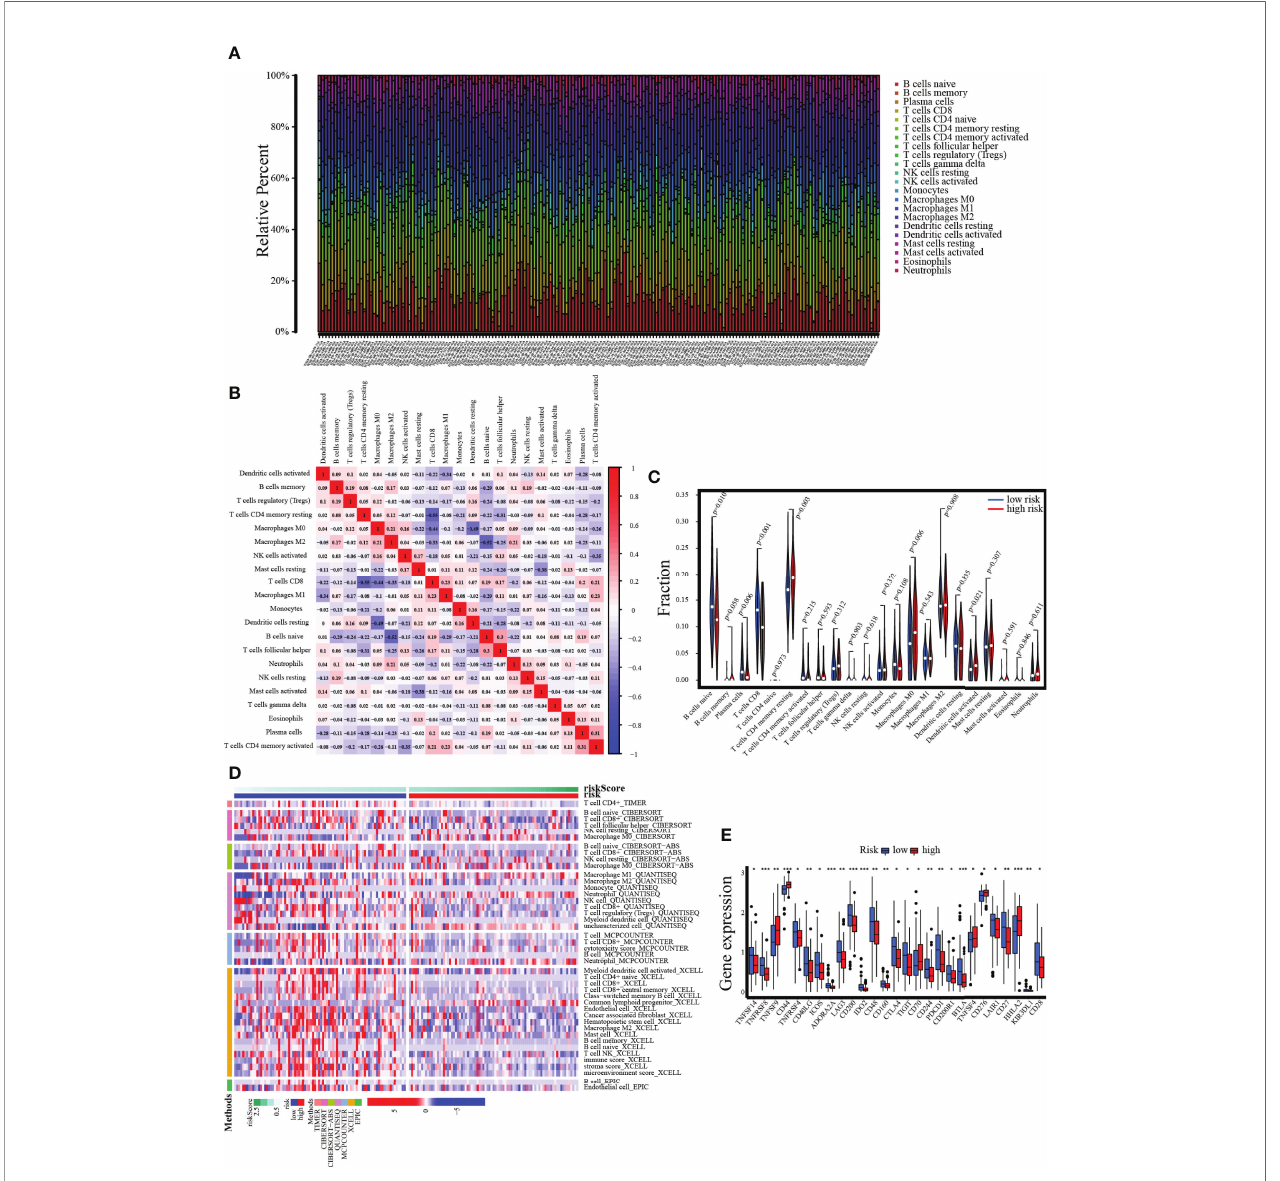
FIGURE 12 | Assessment of tumor-in fi ltrating cells and immunotherapy value. (A) The bar chart reveals the percentage of 22 in fi ltrating immune cells from the TCGA cohort. (B) The correlation matrix shows correlations between in fi ltrating immune cells in tumor samples. (C, D) Violin plot and heatmap present the differentially in fi ltrated immune cells in lower- and higher-risk groups. (E) The differential expression of immune checkpoints between low- and high-risk